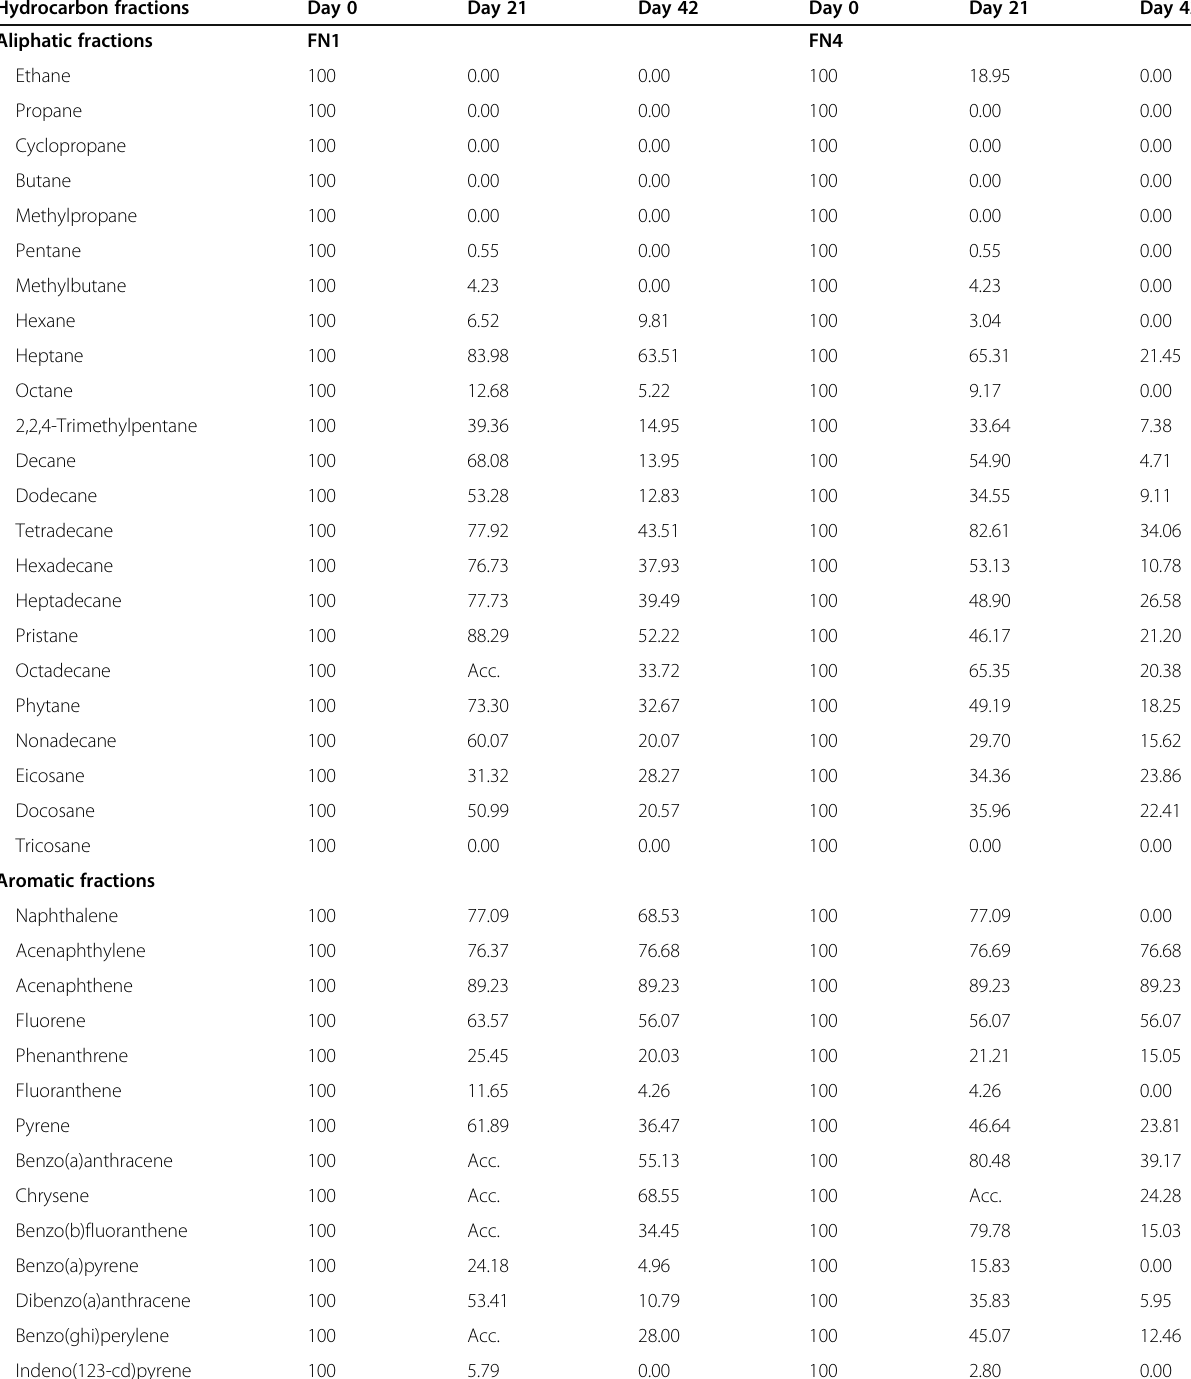
Table 1 Percentage representative aliphatic and aromatic hydrocarbon fractions remaining in the FN1 and CFMM-amended FN4 soil microcosms after 21 and 42 days of incubation at room temperature. Values were calculated from peak areas on day 21 and day 42, respectively, relative to peak area values for day